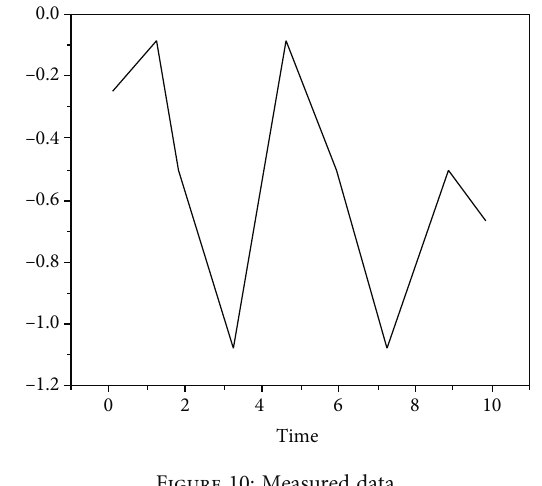
Figure 9: Training accuracy and loss curves. Figure 10: Measured data. Table 4: Variation of de fl ection (node 1).